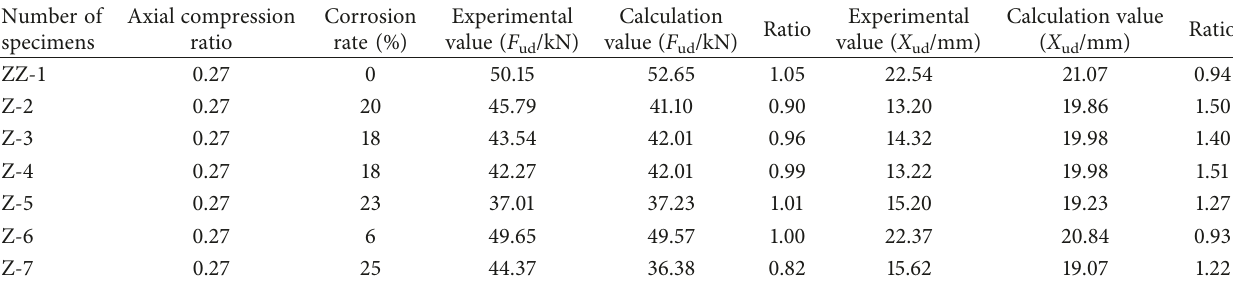
Table 4: The comparison between theoretical value and experimental value.